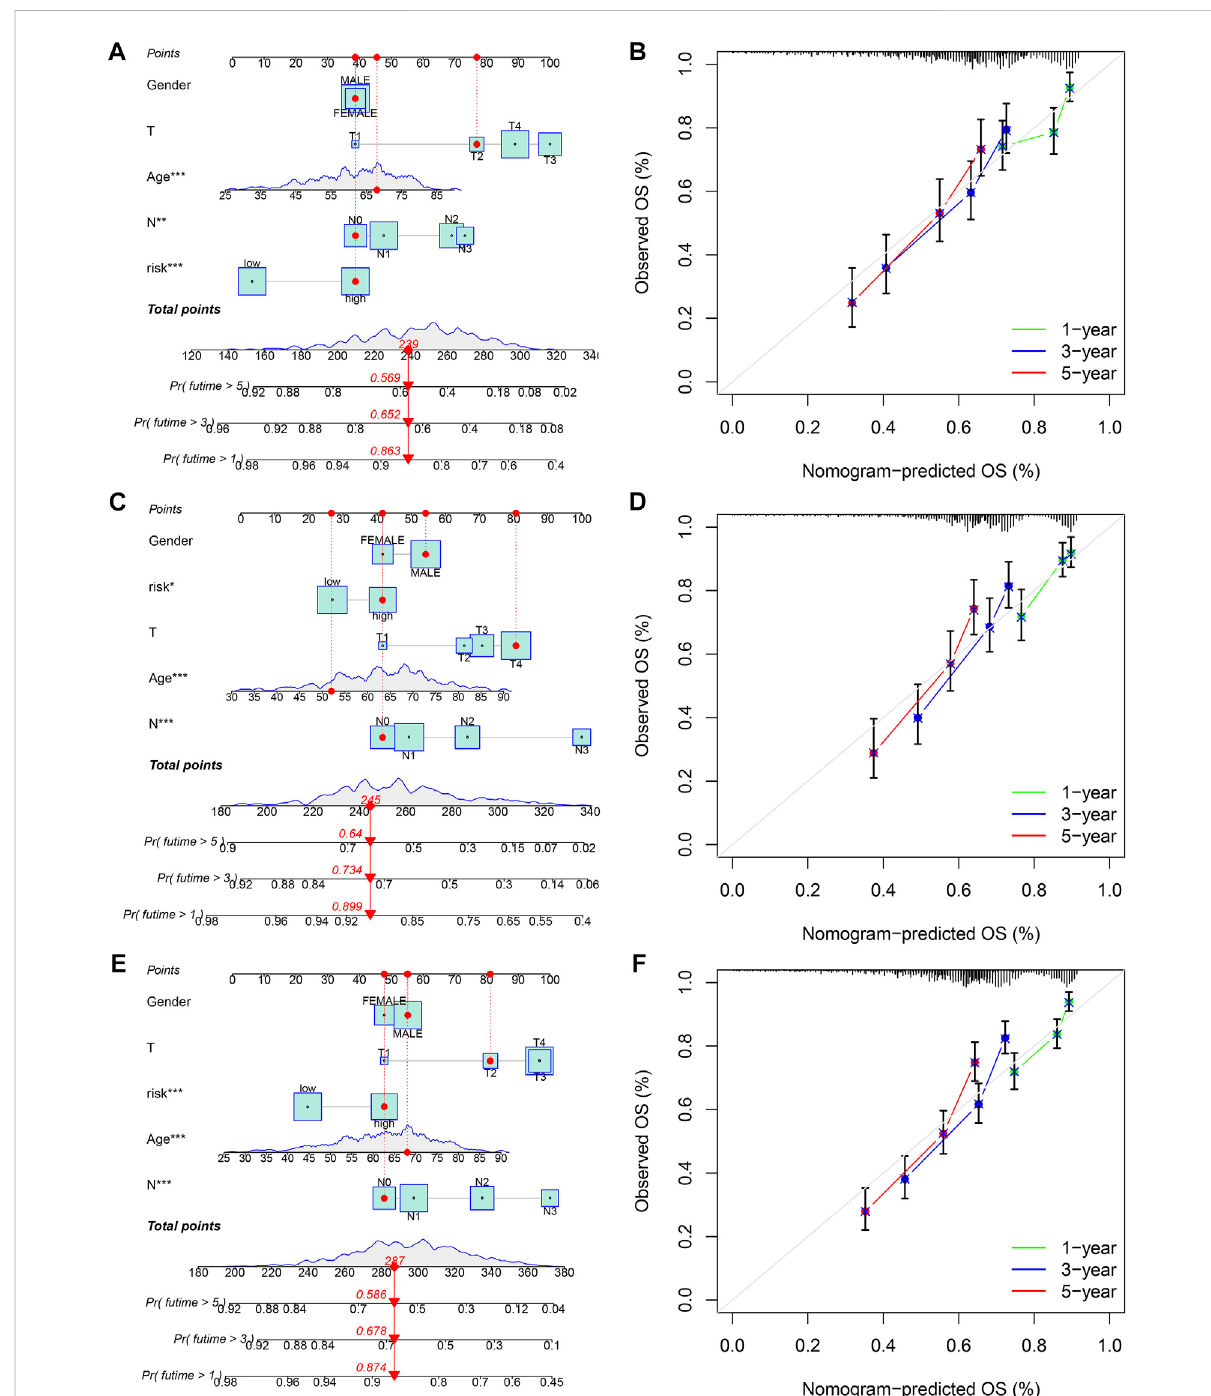
FIGURE 9 Construction and validation of a nomogram for predicting OS in gastric cancer. (A,B) The nomogram combining gender, age, T stage, N stage, and risk score for predicting gastric cancer patient OS at 1-, 3-, and 5- years in the training set, (C,D) testing set, and (E,F) entire set. *p < 0.05; **p < 0.01; ***p <